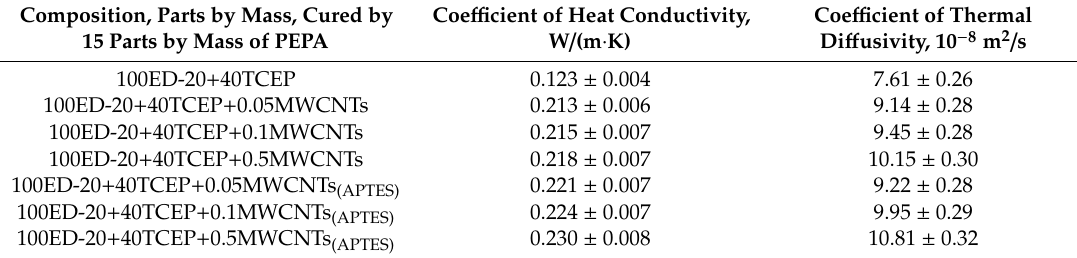
Table 7. Thermal di ff usivity and heat conductivity of composites filled with pristine MWCNTs and APTES-treated